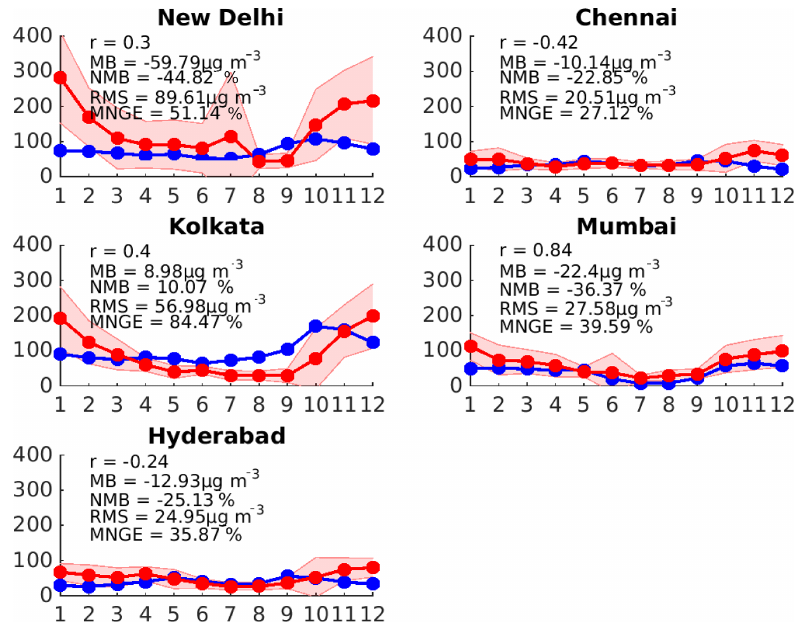
Figure 6. Time series of monthly surface PM 2 . 5 mean concentrations in µgm − 3 for the observations in 2014 (red) and EMEP for the reference scenario (averaged over the period of simulation) (blue) over New Delhi, Chennai, Kolkata, Mumbai and Hyderabad. The red shaded error corresponds to the standard deviation of the measurements. The correlation coefficient ( r ), the mean bias (MB), the normalized mean bias (NMB), the root mean square (RMS) error, and the mean normalized gross error (MNGE) are